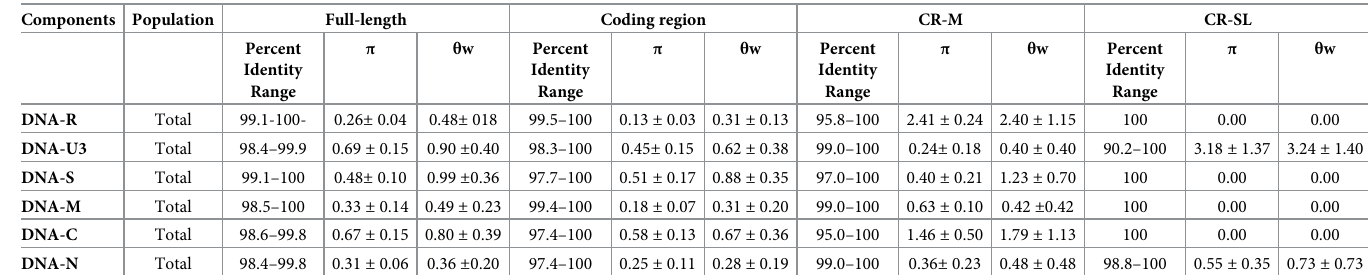
Table 3. Genetic diversity of Banana bunchy top virus population in Pakistan.